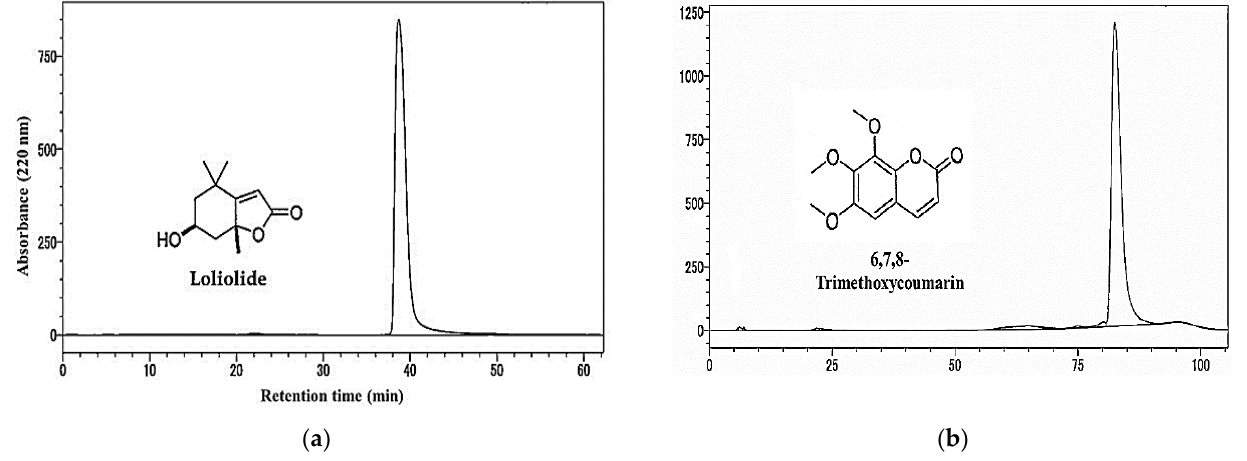
Figure 5. The molecular structure and chromatogram of loliolide ( a ) and 6,7,8-trimethoxycoumarin ( b ) characterized from the T. nudiflora leaf extracts.